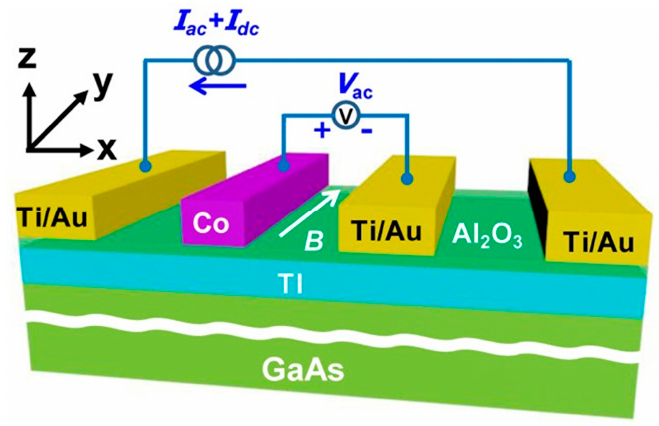
Figure 11. Schematic illustration of the device structure with one ferromagnetic tunneling Co/Al 2 O 3 contact for spin detection [148].